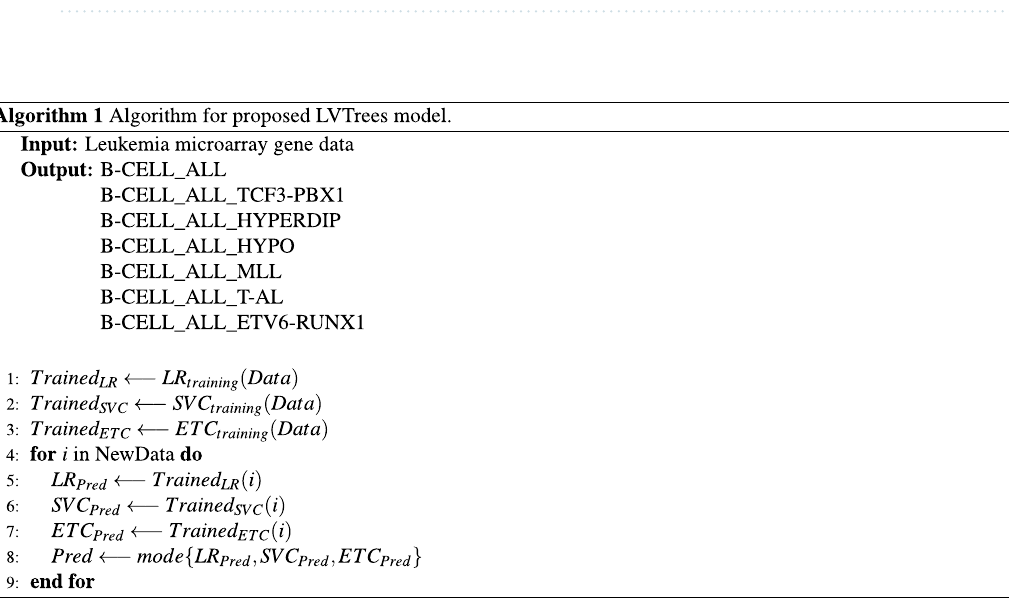
Figure 2. Architecture of proposed hybrid LVTrees